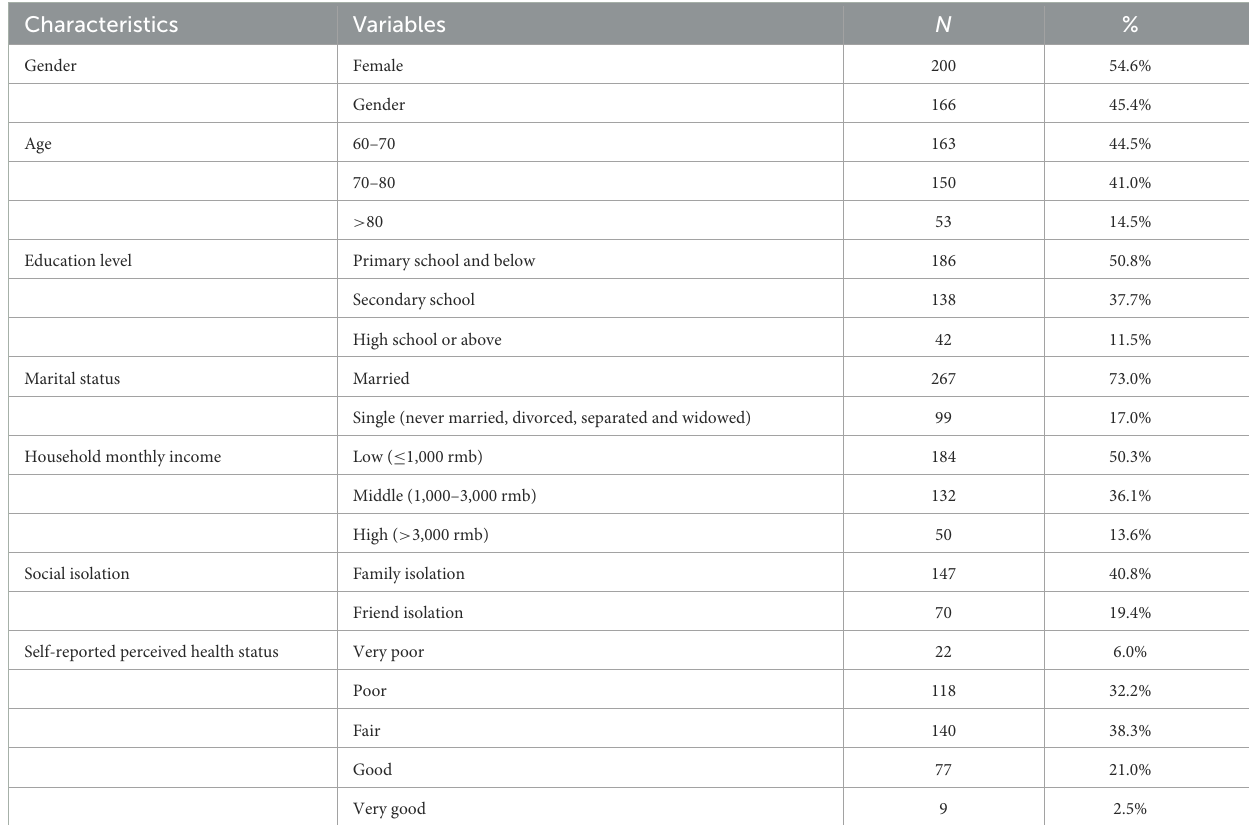
TABLE 1 Characteristics of the study